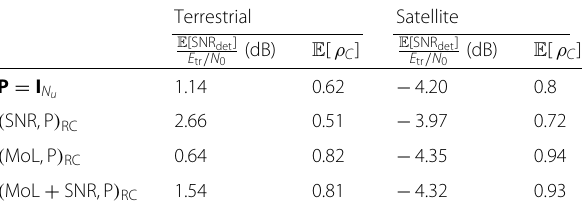
(dB) and E [ ρ C ] when optimizing the row Table 5 E [SNR det ] E tr / N 0 permutation matrix P for